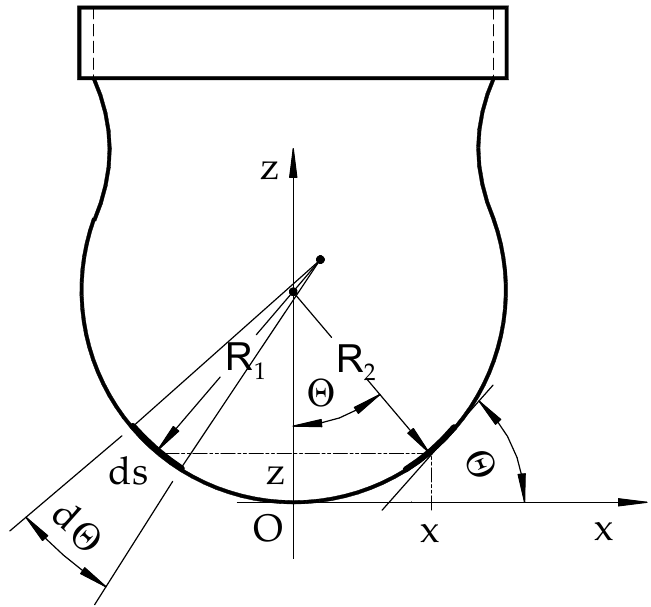
Figure 1. Definitions of the variables in the Bashforth and Adams [16] algorithm. The location of a curvature center for the first radius R 1 is illustrative, and the center may be located in any point along the normal of the arc ds .